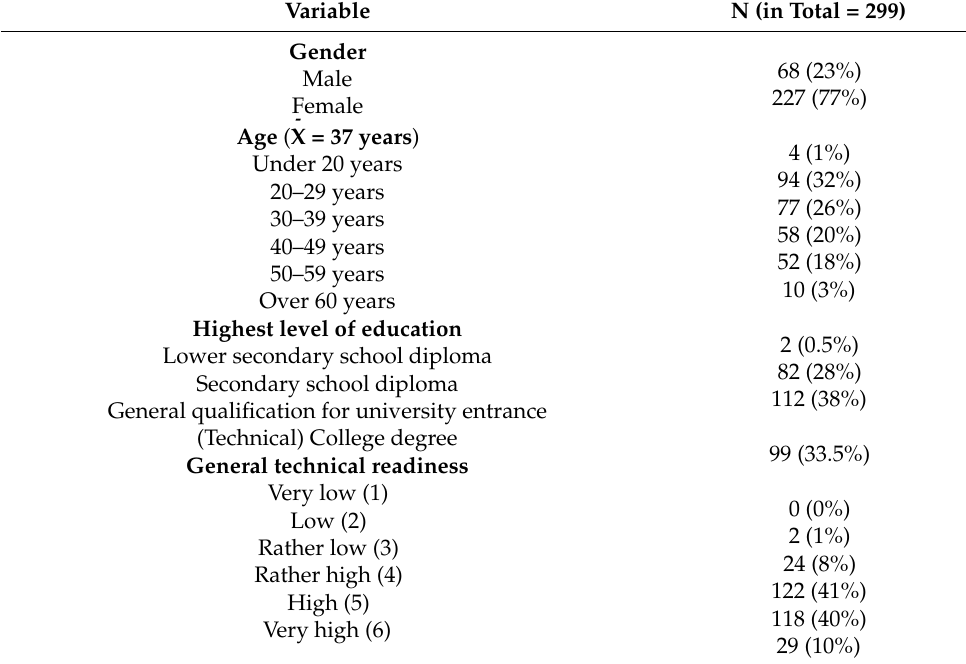
Table 1. Baseline characteristics of